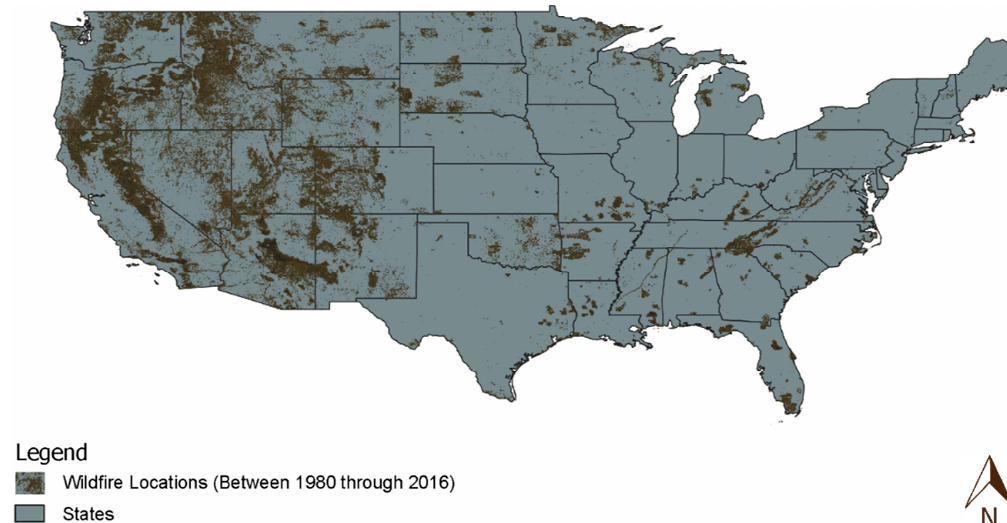
Figure 1. Wildfire locations (1980 through 2016) within the United States.